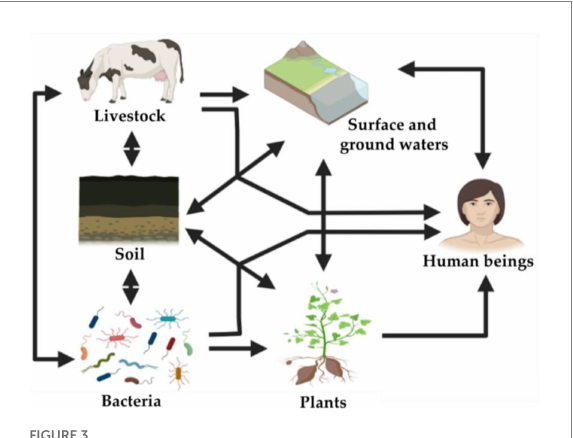
FIGURE 3 Schematic illustration of the associations between some key environmental settings of antibiotic resistant-bacteria and antibiotic resistance genes (ARGs). Acquisition of existing ARGs from the environmental microbiome occur mostly by horizontal gene transfer (HGT). Resistance may also occur in soil bacteria via mutations encoding target-site